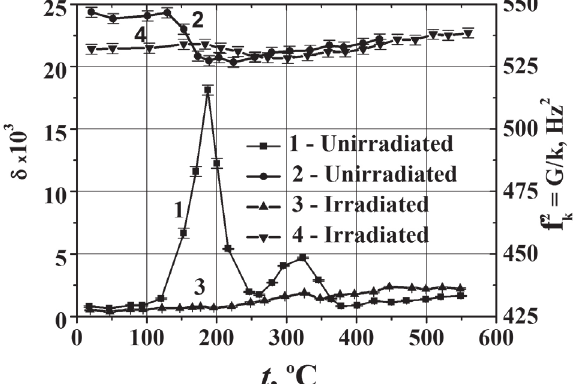
Figure 2. Temperature dependences of internal friction ∆ (1, 3) and the square of the frequency of torsional vibrations f of the unirradiated (Curves 1, 2) and irradiated (Curves 3, 4) niobium samples with the <111>